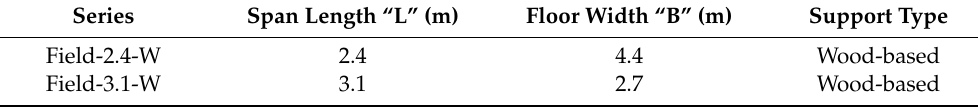
Table 3. Nomenclature, dimensions, and support details of in-situ timber floors.